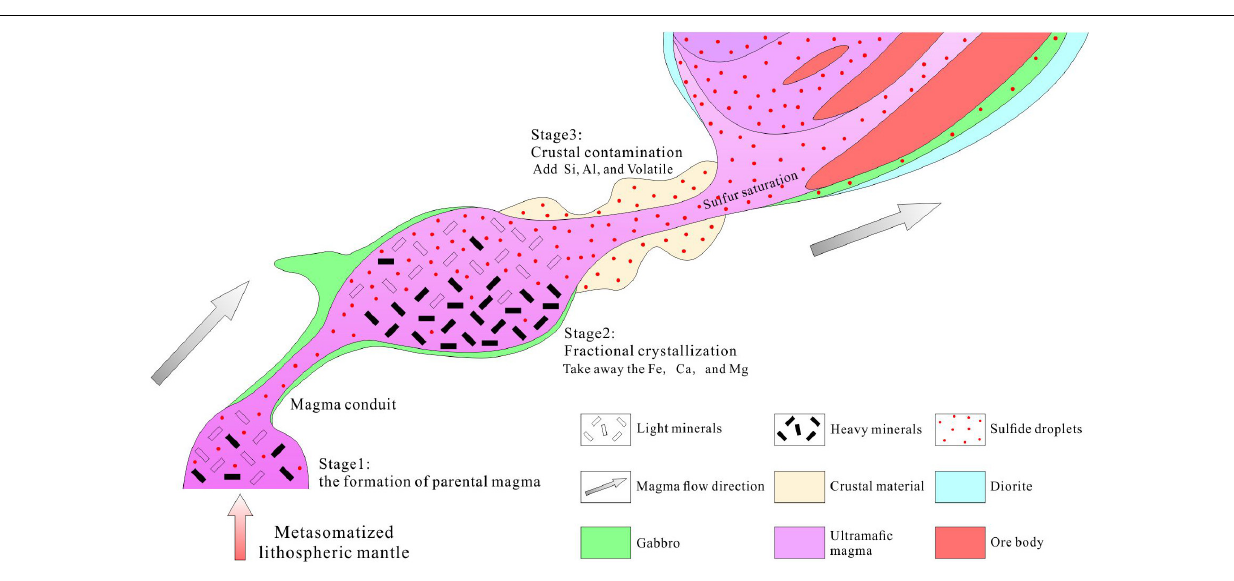
Frontiers in Earth Science |